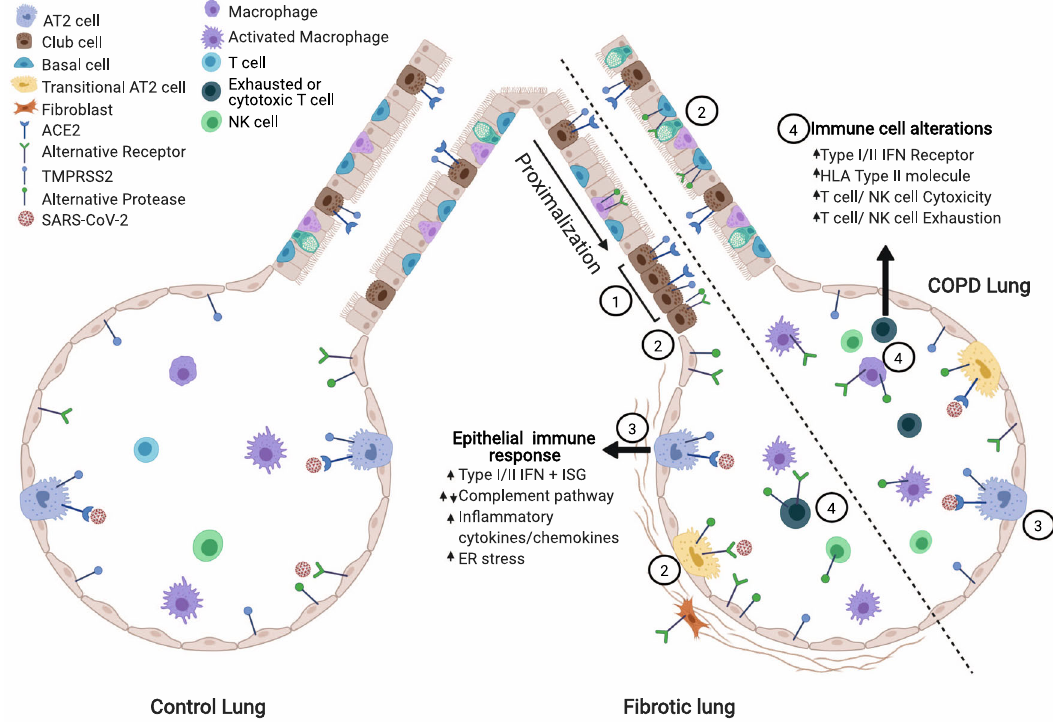
Fig. 5 Model of alterations in the diseased lung related to SARS-CoV2 pathogenesis. ( 1 ) In the IPF lung, there is a proximalization of the distal airway. ACE2 + epithelial cells cluster in the small airways though total ACE2 + cell numbers are similar to control. ( 2 ) The viral entry score (accounting for all described putative receptors and proteases) is increased in diseased lungs. ( 3 ) Diseased epithelial cells have alterations in key SARS-CoV-2 response genes/pathways. ( 4 ) In the CLD lung, there is increased expression of cytotoxicity and exhaustion genes in immune cell populations and alterations in viral response pathways (interferon, antigen presentation). Figure created in